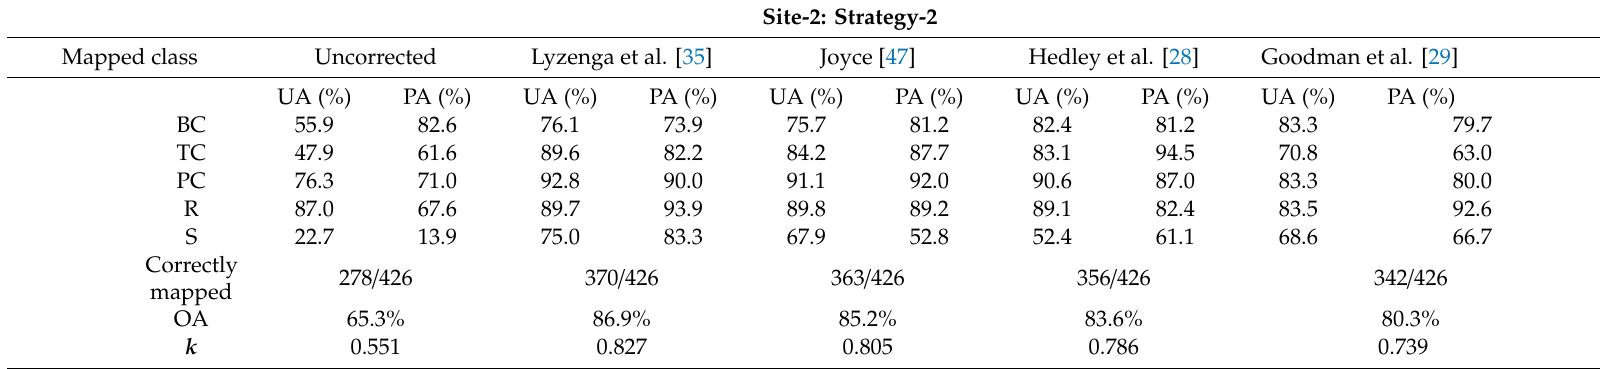
Table 4. Summary of confusion matrices for the external validation site (Site-2 Pantai Vietnam) benthic habitat maps using the sun glint uncorrected dataset, and sun glint-corrected datasets (applying Strategy-2). The mapped classes abbreviations are as described in Table S2 (Supplementary Materials); BC = branching coral